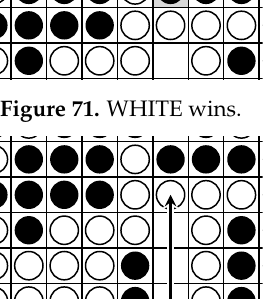
Figure 72. WHITE checkmates.